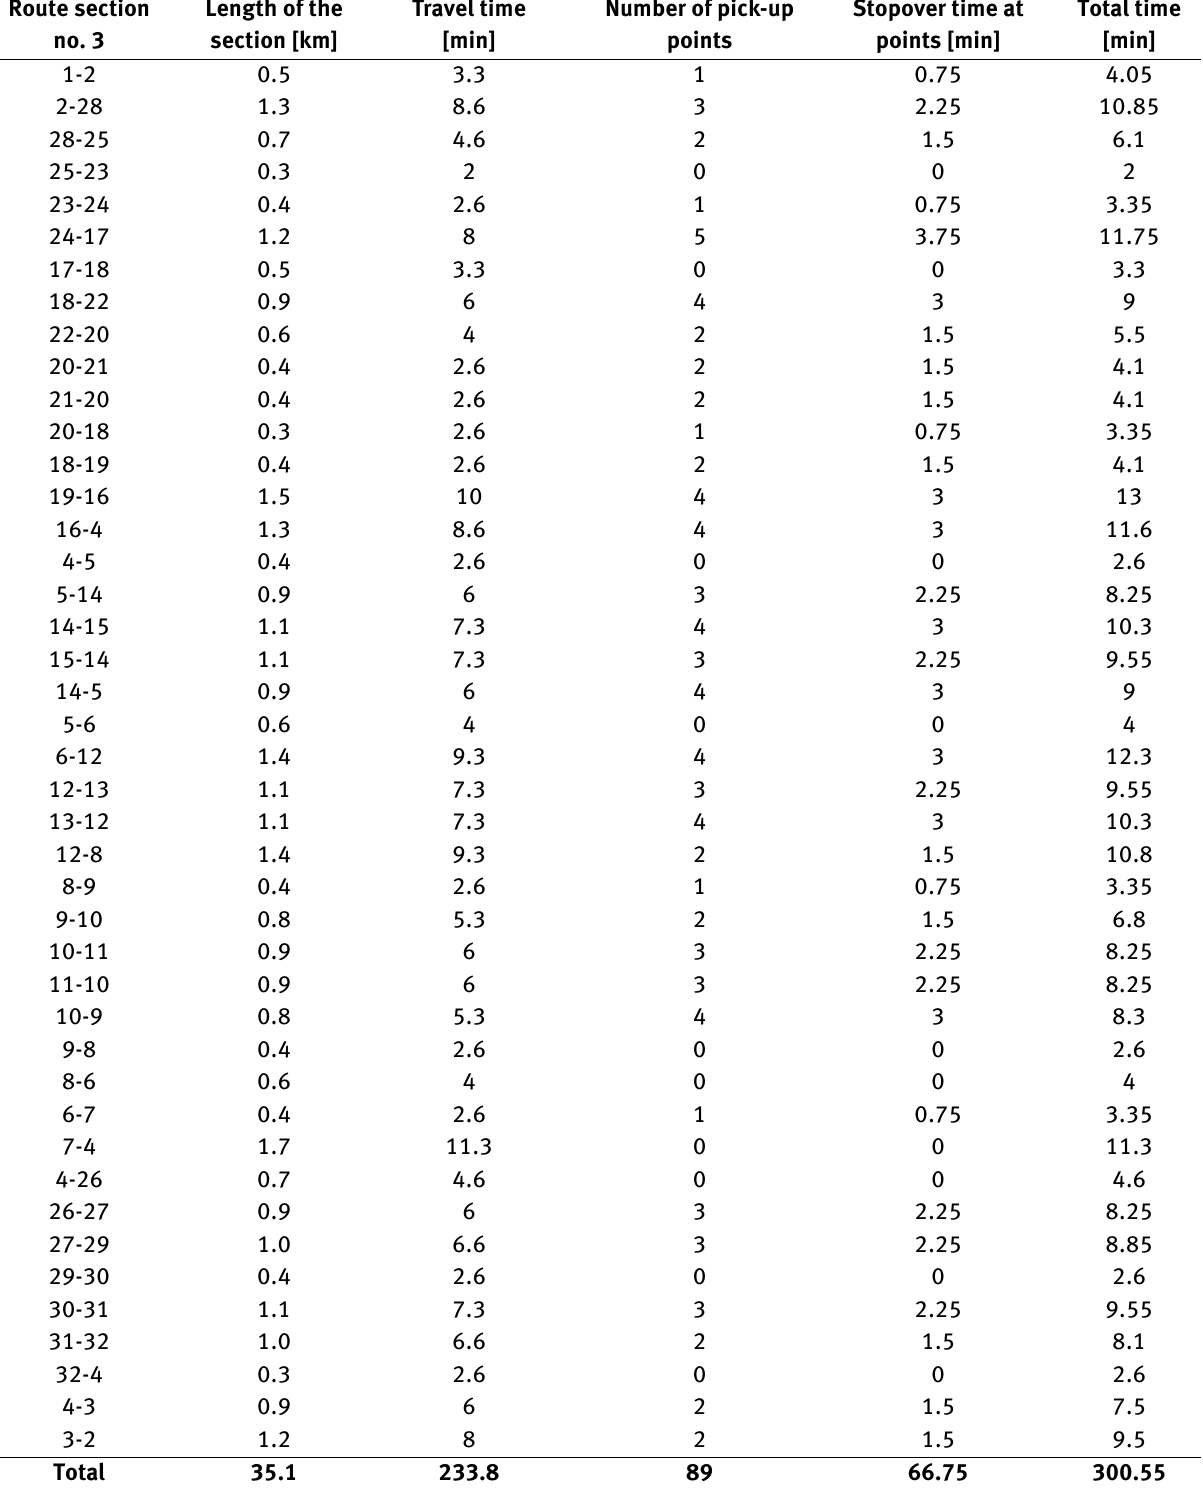
Table 3: List of the route followed by MZGK employees during the collection of mixed waste Route